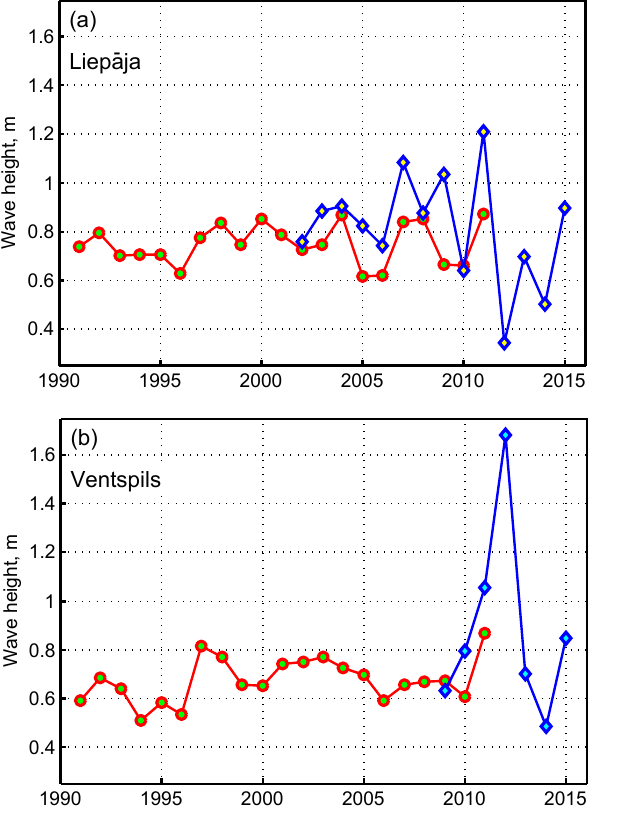
Figure 6. Local spatial variability of wave climate in the Baltic Sea. (a) Changes (m) in the average SWH from 2009–2011 to 2011– 2013. (b) Changes (m) in the mean SWH from 2011–2013 to 2014– 2015. Open circles indicate the pixels hosting a statistically signifi- cant (at a >95% level) increase or decrease.